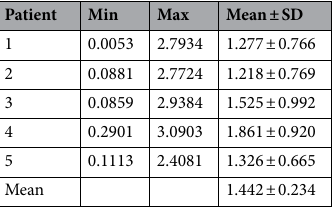
Table 2. Errors between the planned and post-operative outcomes (mm).